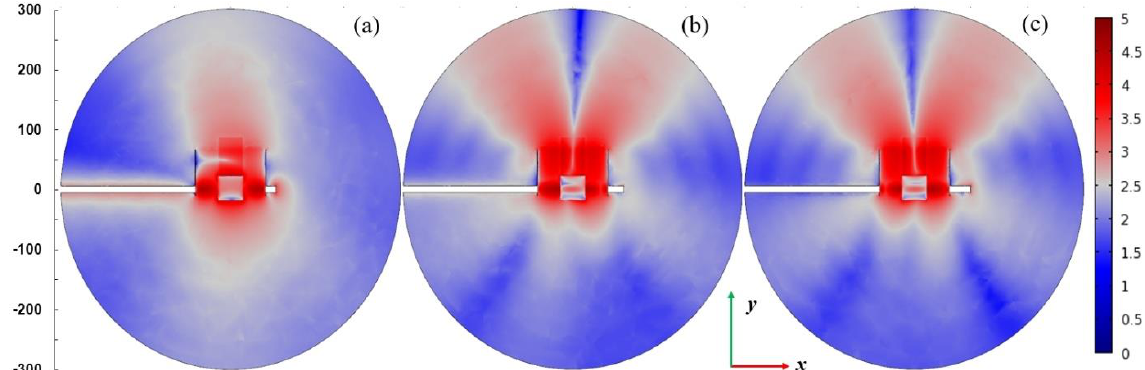
Figure 7. Spatial distributions of the log10 of |E|/(1 Vm −1 ) in x - y plane passing through the center of the plasma for P ent = 100 W. ( a ) L = 15 mm, ( b ) L = 25 mm, and ( c ) L = 35 mm. The coordinate system is the same as in Figure 4. The scale on the left shows dimensions in mm.